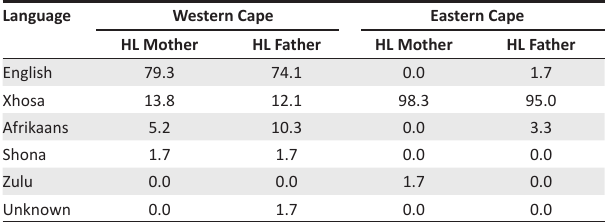
TABLE 1: Home languages spoken by Grade 3 learners’ parents (percentages) ( n = 118). Language Western Cape